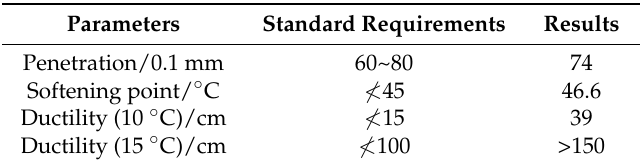
Table 1. Technical indices of asphalt